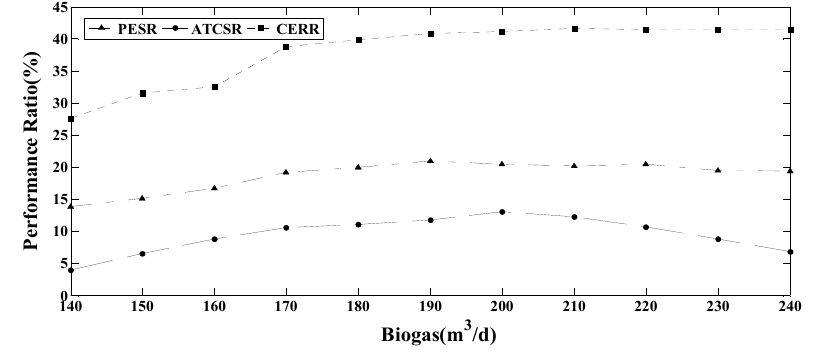
Figure 11. Sensitivity analyses of biogas.